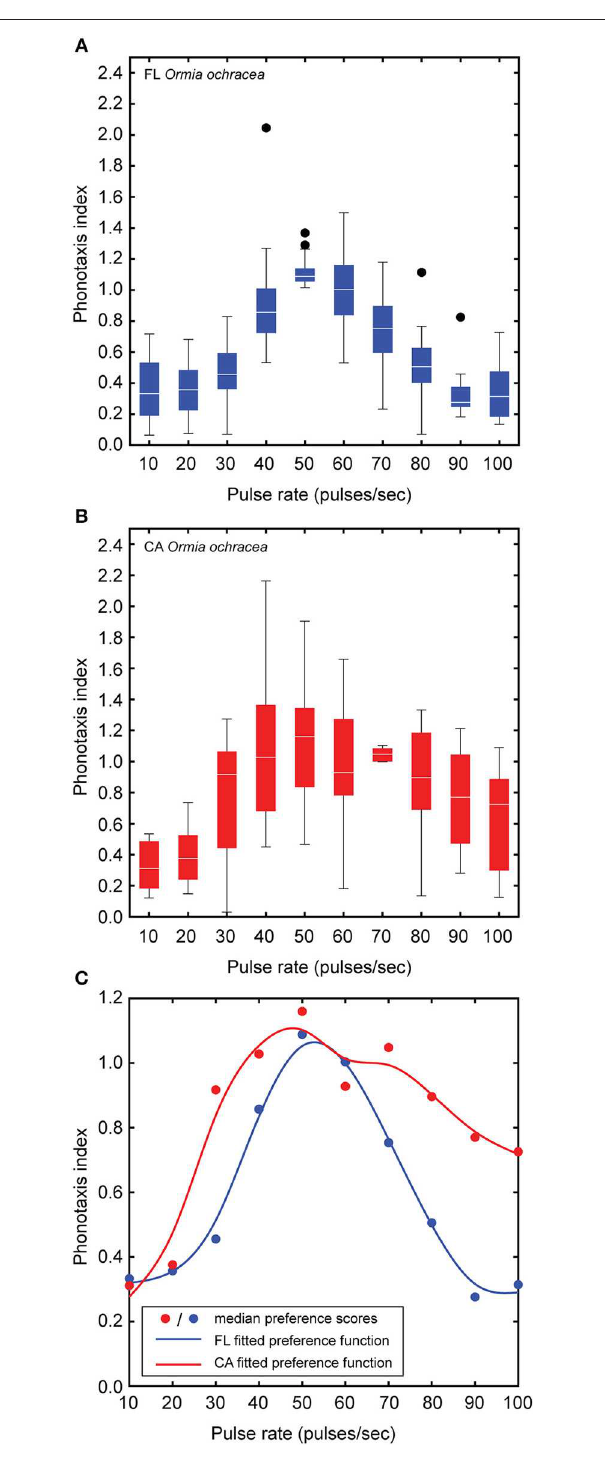
FIGURE 6 | Effects of song pulse rate on the phonotaxis performance index. Box plots depict the first and third quartiles and median phonotaxis index values obtained from Floridian (A) and Californian (B) Ormia ochracea . (C) A smoothing cubic spline was fitted to median phonotaxis index values to generate pulse rate preference functions. Whiskers show the most data extreme points that are not considered outliers, and closed circles indicate